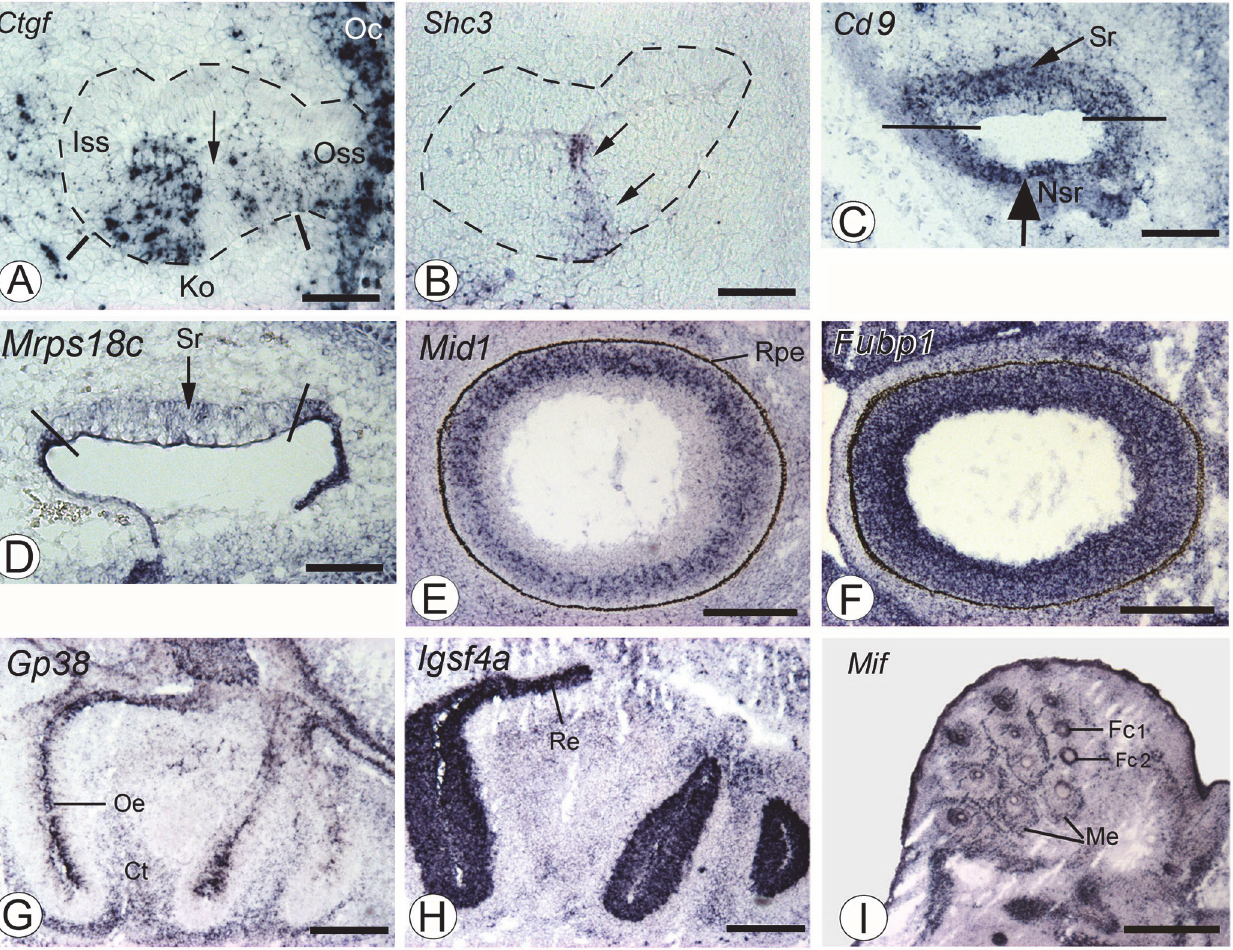
Fig 4. ISH images illustrating gene expression patterns in sensory organs. Gene names are indicated in the upper left part of the image. A,B: Kölliker organ (Ko). The basal cochlear canal is delineated by dashed lines. Ko is found in the ventral region (delineated by two bars). Patchy expression of Ctgf (Connective tissue growth factor) restricted to Ko extending toward the outer spiral sulcus (Oss) and the otic capsule (Oc) and absent in the inner spiral sulcus (Iss). The arrow highlights a region devoid of Ctgf expression in Ko. This latter region expresses Shc3 (Src homology 2 domain-containing transforming protein C3) (arrows in B). Scale bar: 50 μ m. C,D: Utricle. Cd9 (Cd9 antigen) is expressed both in the prospective sensory (Sr, arrow) and non- sensory (Nsr, large arrow) regions. Lines: separation between Sr and Nsr. Mrps18c (mitochondrial ribosomal protein S18C) is weakly expressed in Sr